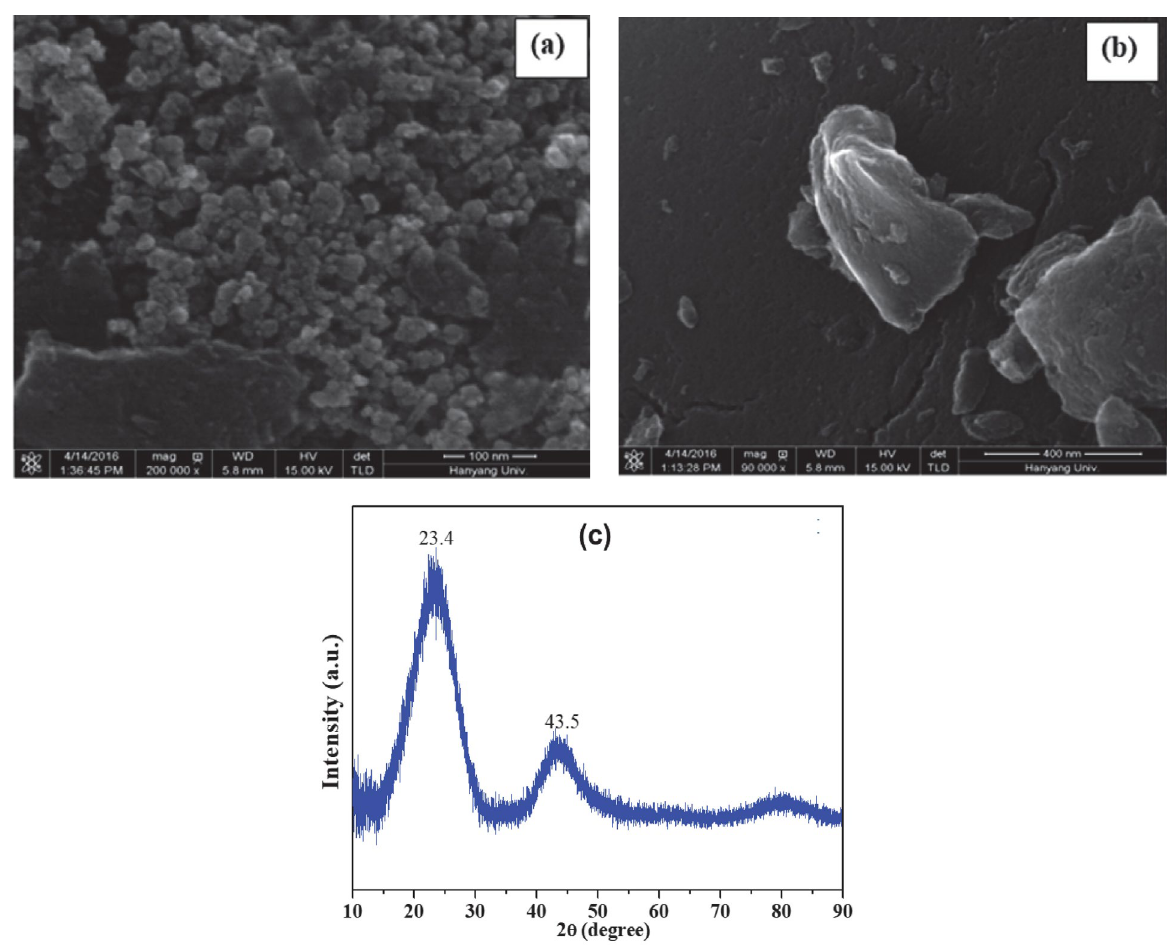
Figure 2. SEM images of GCM (a & b) and XRD spectra (c) of GCM.